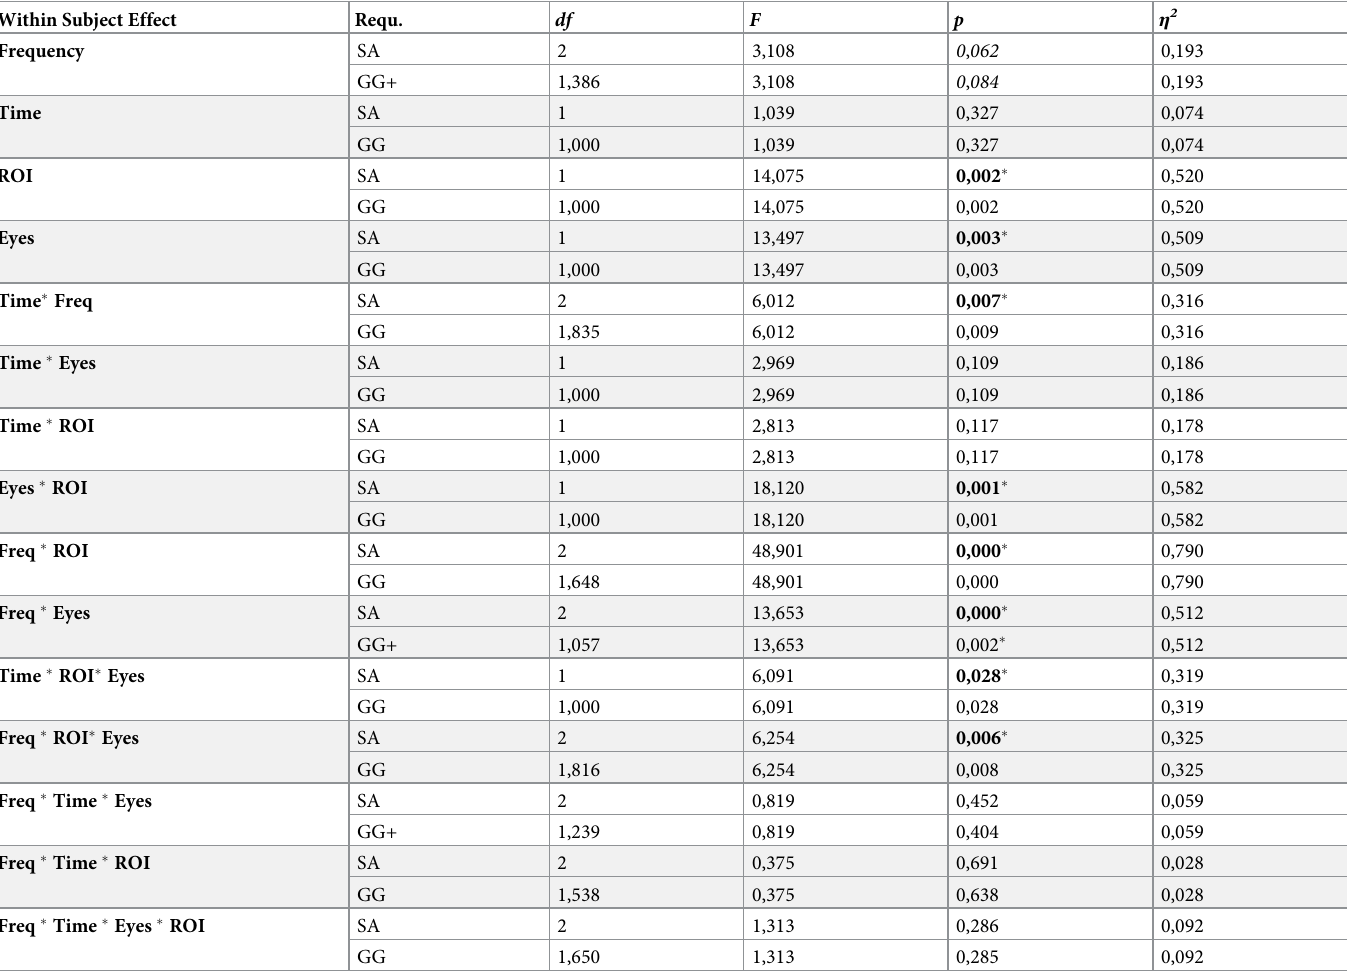
interesting results: the lower the subjects scored on the Lifestyle Facet (EO: r = -.770, p = .001) and the Antisocial Facet (EO: r = -.594 p = .025), the more they could increase midline alpha band power over the course of SCP training. No significant relationships regarding the Psy- chopathy Total score or the Affective or Interpersonal Facets were found. The opposite pattern was found for the slower frequencies: the reduction in delta band activity at parietotemporal sites was significantly correlated with the PCL-R Total Psychopathy score (EC: r = -.566, p = .035) and the Affective Facet (EC: r = -.671, p = .009). These relation- ships indicate that the higher the subject’s score on psychopathy (especially a greater lack of Table 1. Repeated-measures analysis of